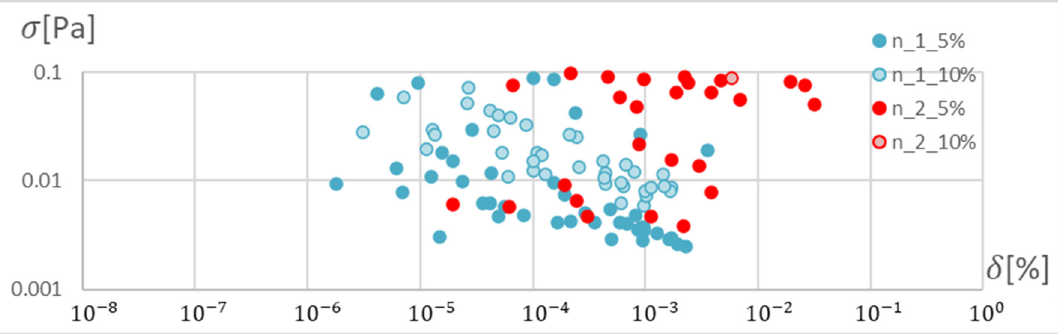
Figure 19. Pareto front for the two best-matched networks trained using the RPROP algorithm.